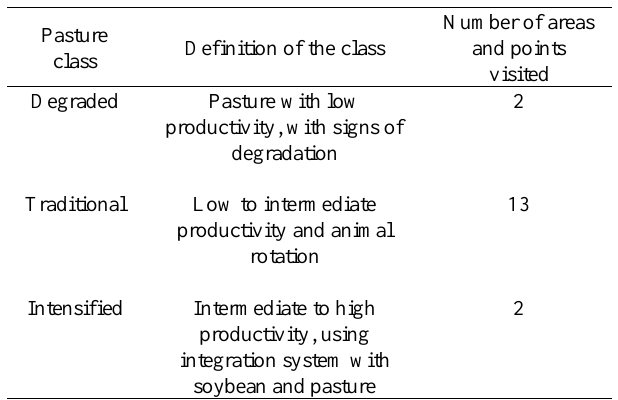
Table 1. Field areas and points visited in each pasture